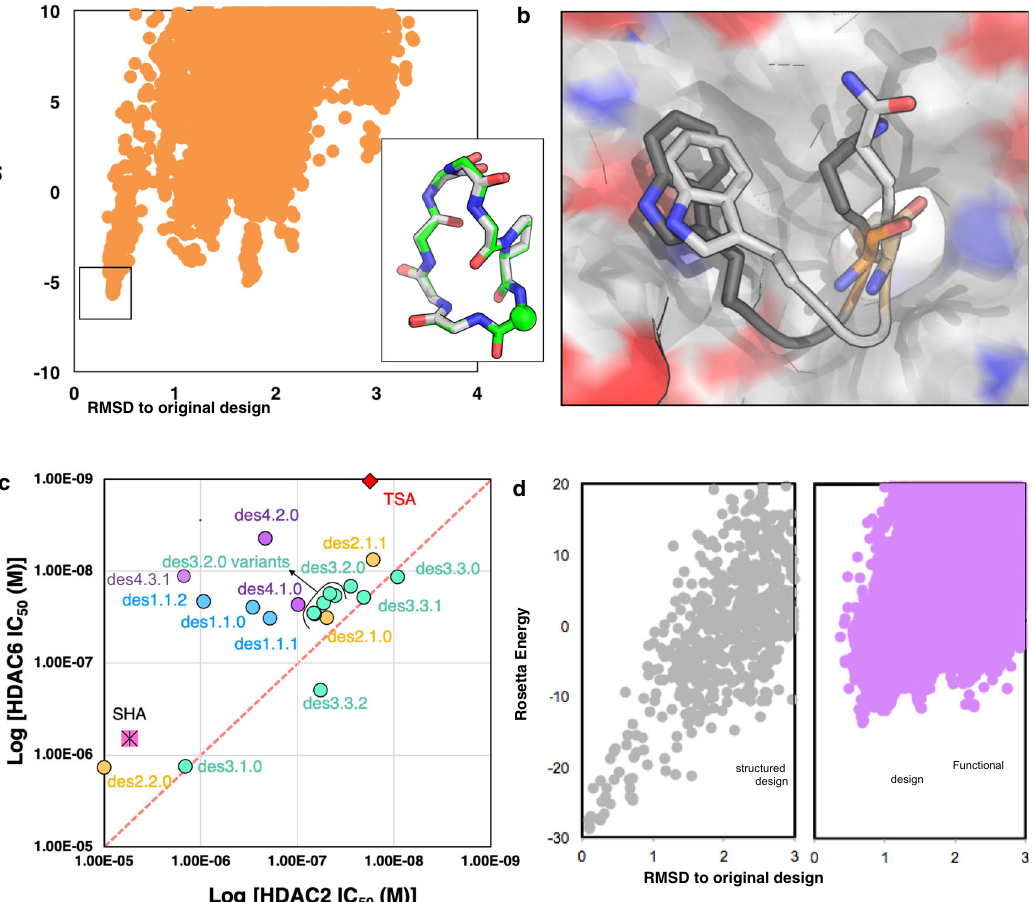
Fig. 5 Improvements in scoring, structure sampling, and binding orientation sampling should increase design binding af fi nity and selectivity. a Conformational sampling of des1.1.0 (Source Data are provided as a Source Data fi le). Inset: Overlay of the crystal structure (gray) and the best scoring model (green). The CA atom of the SHA anchor is shown as sphere for reference. b Overlay of predicted binding orientation from our large-scale parallel docking (dark gray) with crystal structure (light gray) of des1.1.0 shows that docking can accurately predict orientation of key residues at the interface. c Despite improvement of the IC 50 values over the original SHA anchor (pink square), most designs follow the same trend as SHA; binding slightly more tightly to HDAC6 over HDAC2. Different colors show results of designs from different methods (blue = method 1, orange = method 2, green = method 3, purple = method 4). TSA (Trichostatin A, red diamond), a pan-HDAC inhibitor, is shown as a control. d Comparison of computational conformational sampling for a structured (gray) and a functional (purple) macrocycle shows a much deeper energy gap for structured macrocycle compared to the functional macrocycle (Source Data are provided as a Source Data fi